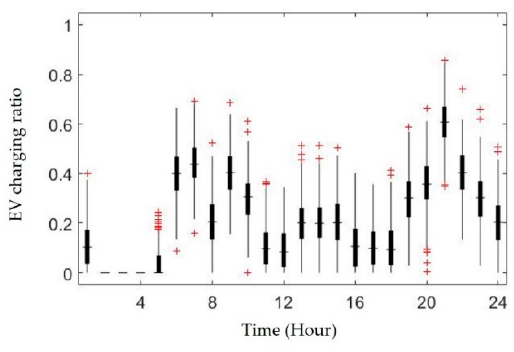
Figure 2. Statistical information on annual EV charging pattern of Case B.